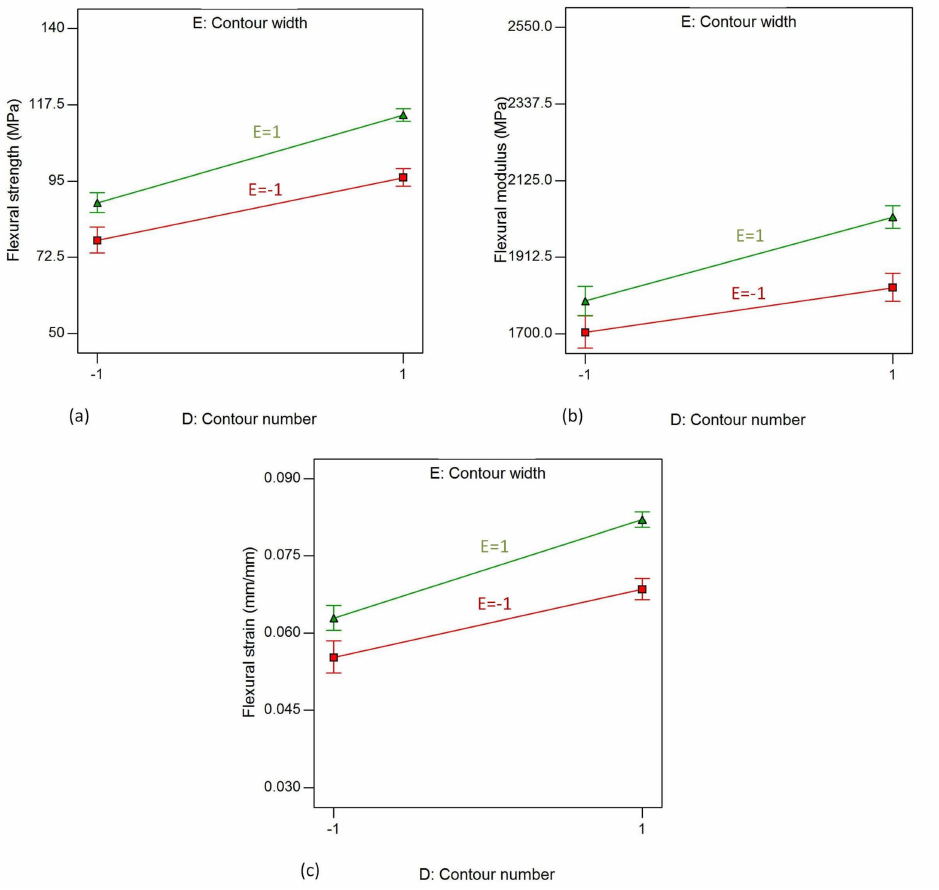
Figure 19. Interaction effect of contour number and contour width on ( a ) flexural strength; ( b ) flexural modulus and ( c ) flexural